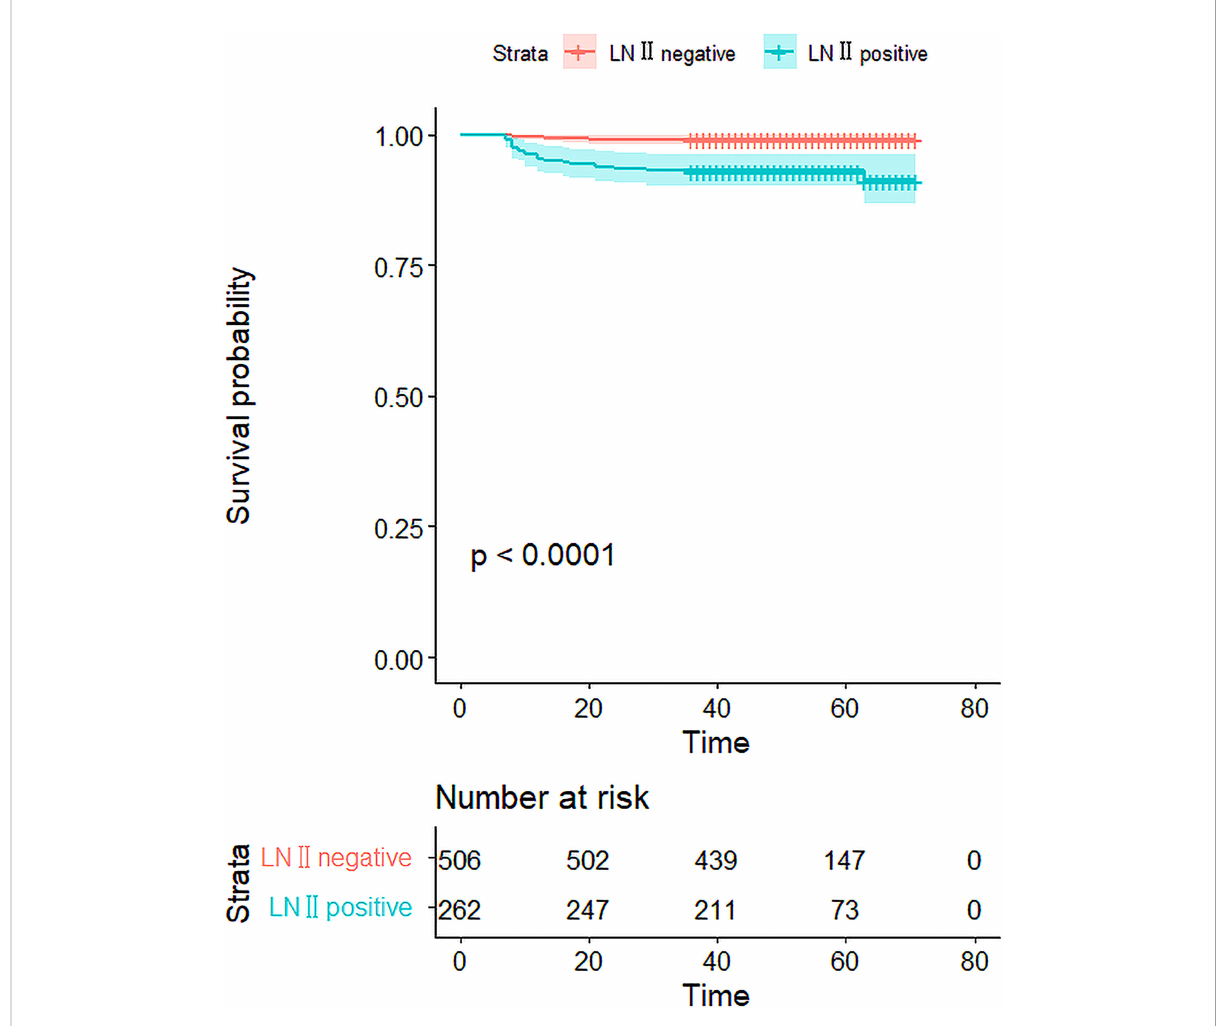
FIGURE 4 The Kaplan – Meier curves for the 768 patients. The curves show that the DFS rate was 96.9% in 768 patients, and there was a signi fi cant difference in the DFS rate between the LN-level negative and positive